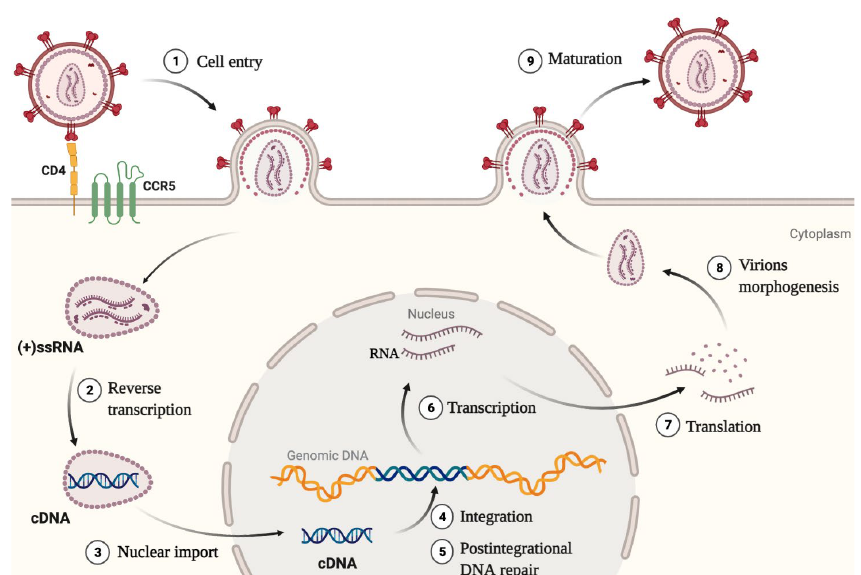
Figure 1. Schematic representation of HIV-1 life cycle. The early replicative stages include binding of the virion to the CD4 receptor and fusogenic co-receptor (CCR5 or CXCR4), cell entry, reverse transcription that induces the subsequent capsid rearrangement and uncoating of PIC before arriving at the nuclear pore, at the nuclear pore complex during the nuclear import of PIC or inside the nucleus (see Section 6), cDNA integration into actively transcribed regions of the cellular genome, and post-integration DNA repair that results in the provirus formation. The late replicative stages include transcription of the viral full-length genomic RNA (gRNA), formation of partially and fully spliced viral mRNA, export of viral gRNA and mRNA, protein synthesis, virion assembly, budding, and maturation.